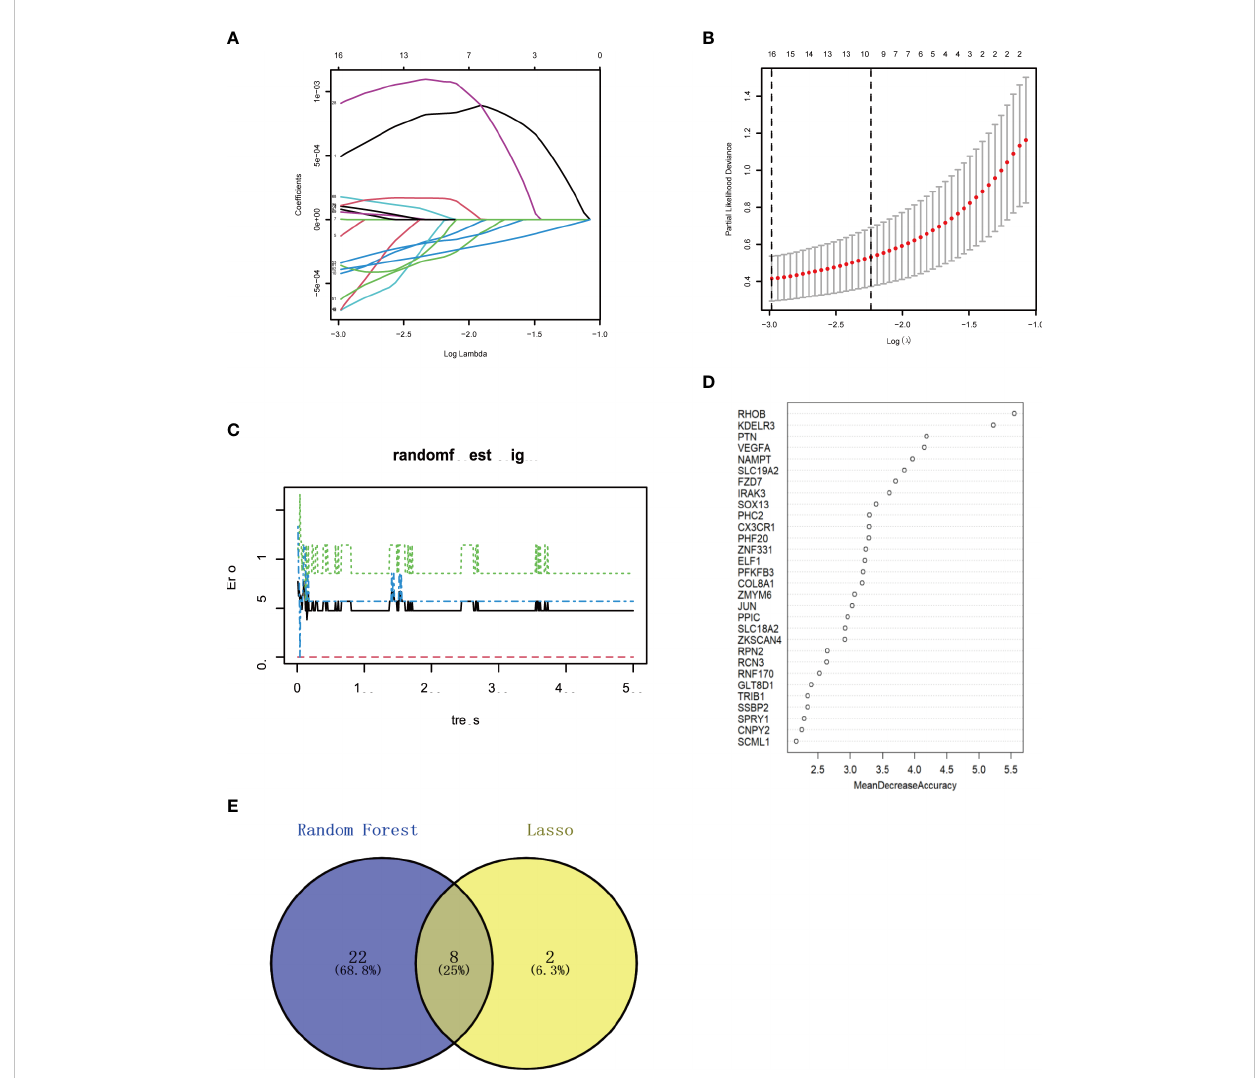
FIGURE 6 Machine learning in screening candidate diagnostic biomarkers for OA with MetS (A, B) Biomarkers screening in the Lasso model. The number of genes (n-10) corresponding to the lowest point of the curve is the most suitable for OA with MetS diamos. (C, D) The random forest algorithm shows the error in OA; control group and genes are ranked based on the importance score. (E) Venn diagram shows that eight candidate diagnostic genes are identi fi ed via the above two algorithms OA. Osteoarthritis: MetS Metabolic